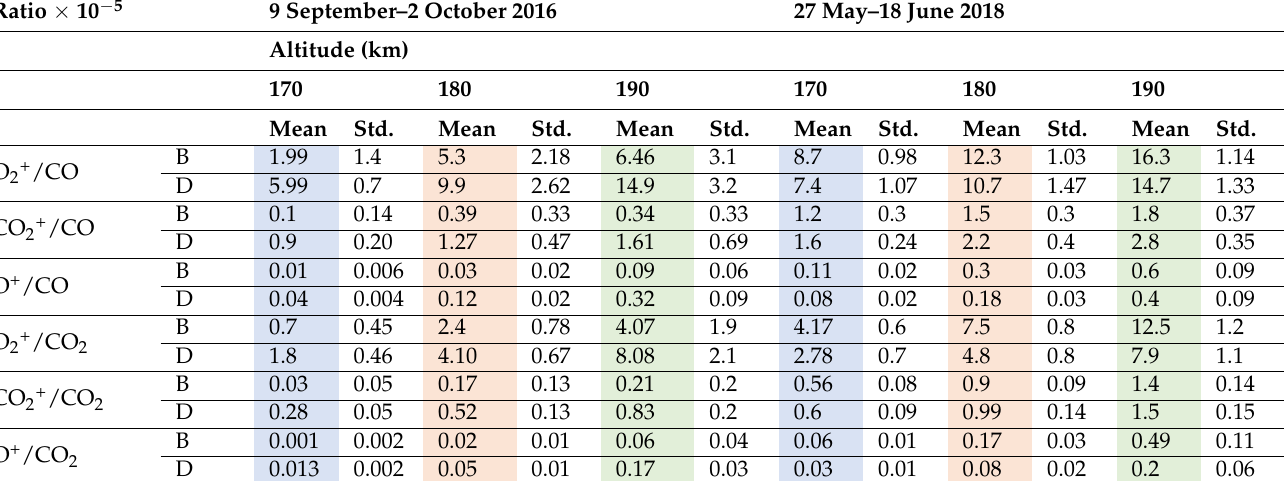
Table 2. Mean and standard deviation of O 2+ , CO 2+ , O + to CO and CO 2 from 9 September–2